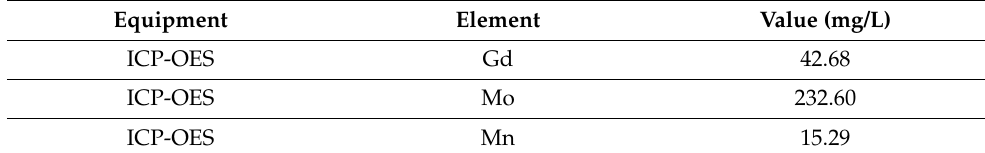
Table 2. ICP-OES results of